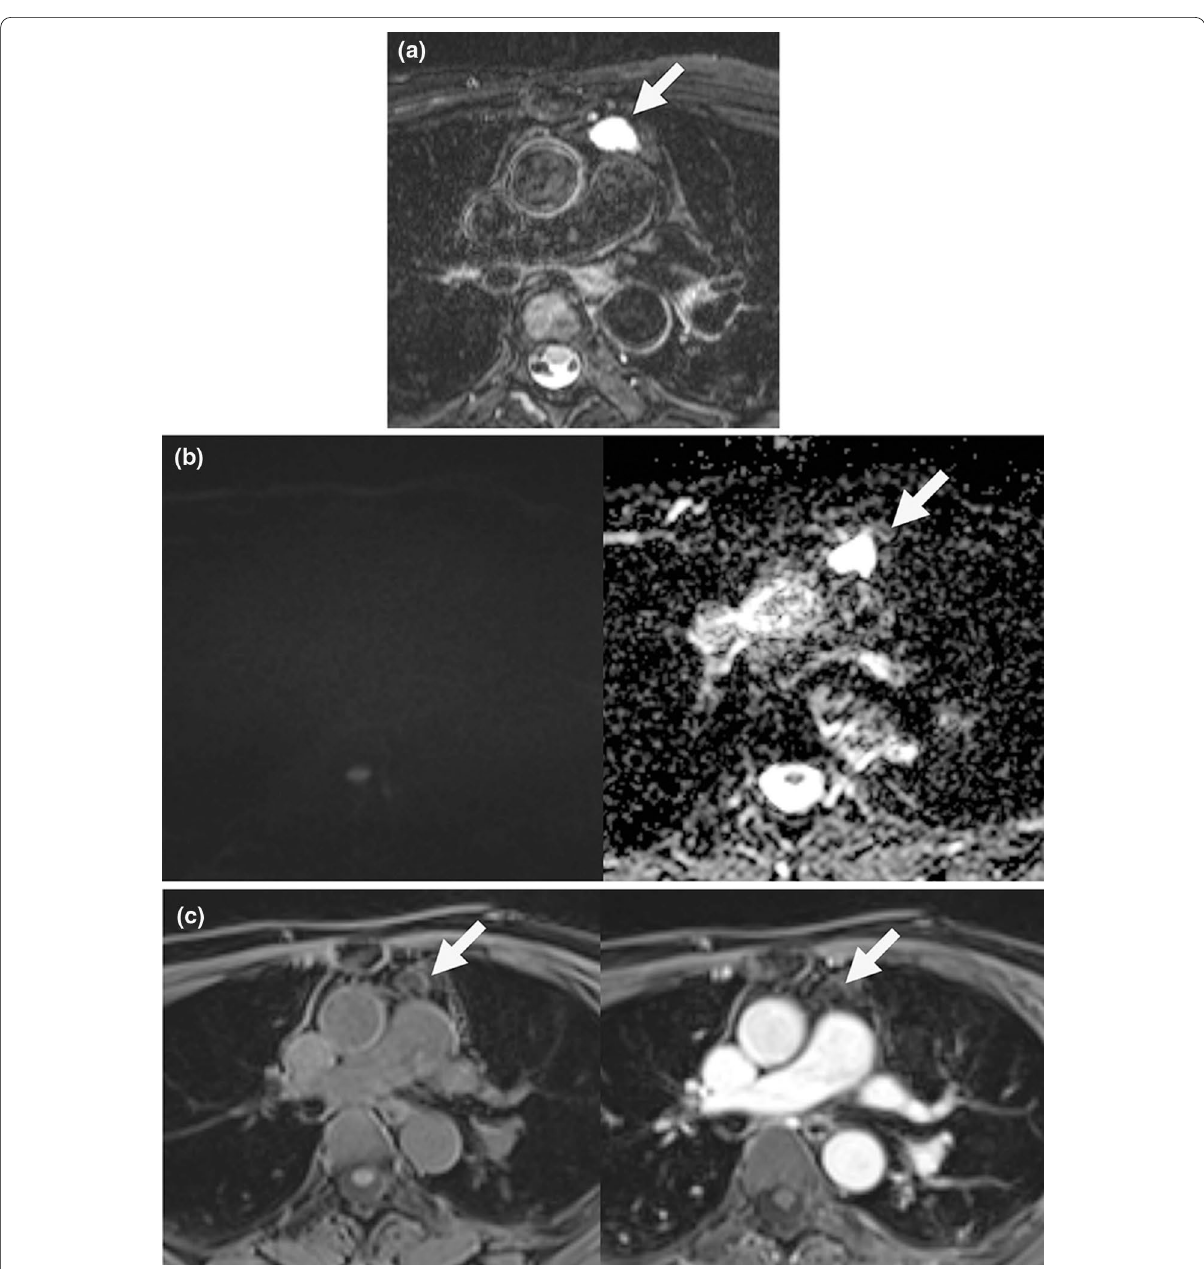
Fig. 2 MR findings of probable cyst (simple cyst, category 1) and indeterminate lesions (complex cyst, category 2). Chest MRI in a 50-year-old female ( a – c ) shows 22-mm well-defined, ovoid, and unilocular lesion (arrows) in the anterior mediastinum showing homogeneous high signal intensity on T2-weighted image ( a ) and no remarkable diffusion restriction on high b-value (b1000) diffusion-weighted image and high apparent diffusion coefficient (ADC) value ( b ). The lesion shows intermediate signal intensity on pre-contrast T1-weighted image, and no remarkable enhancement on post-contrast T1-weighted image ( c ). The lesion can be classified as a probable cyst based on chest MRI findings. Chest MRI in a 65-year-old female ( d – f ) shows a 43-mm lobulated and multilocular lesion in the anterior mediastinum showing internal high signal intensity on T2-weighted image (arrow, d ) and no remarkable diffusion restriction ( e ). The lesion shows intermediate signal intensity on pre-contrast T1-weighted image and diffuse enhancement along cyst wall, and septa with a nodular solid enhancement attached to the right lateral side of the cyst wall on post-contrast T1-weighted image (arrowhead, f ). The lesion can be classified as an indeterminate lesion based on chest MRI findings. The patient underwent thymectomy one month after chest MRI. On gross pathology, the cystic mass was well-defined and multiseptated with a focal solid portion and sebaceous material. The cystic mass was compatible with the thymic cyst on